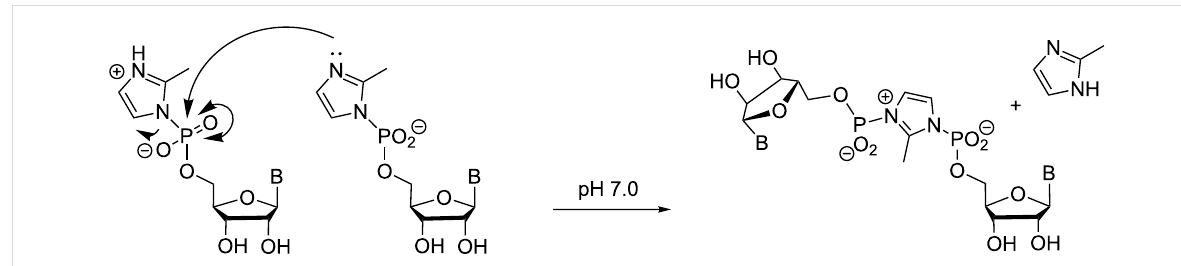
Figure 12: Formation of a highly reactive methylimidazolium bisphosphate from methylimidazolides of nucleotides.